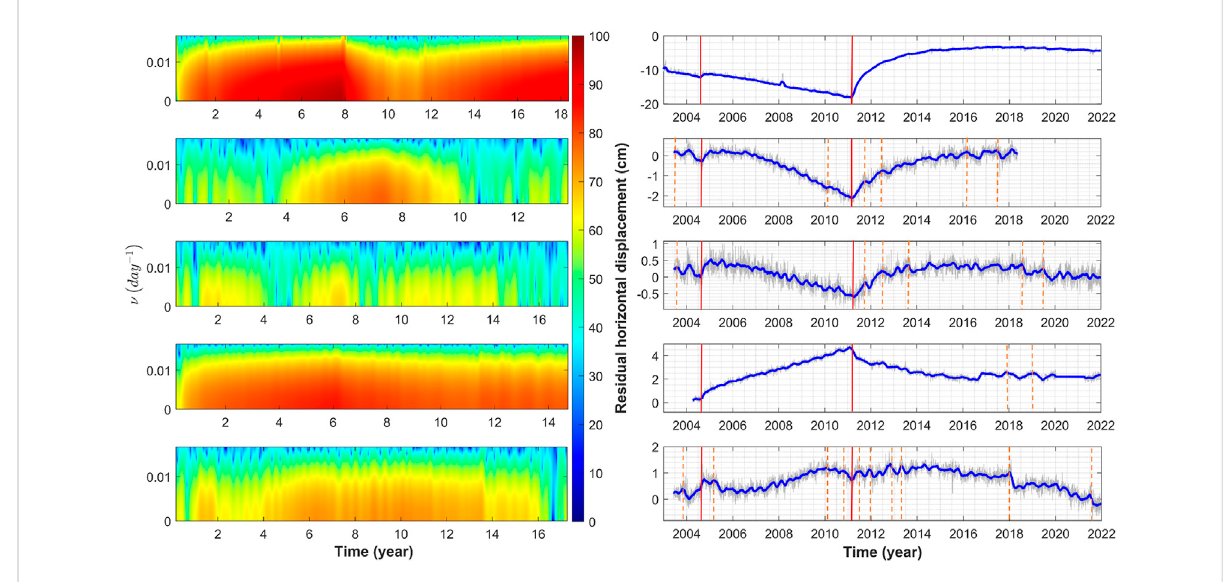
FIGURE 11 Spectrogramsanddetrendedhorizontalgeodetictimeseriesof fi veGNSSstationsintheNankairegion.Fromtoptobottom:USUD,G116,G117,SMST,and G120.SSEsareobserved(2004,2010,and2019);moreover,thespectralamplitudesarenoticedtoincreasebeforetheGiantTohoku-OkiEarthquake(11/03/2011, M w 9.0) in the recordings of stations to the north and nearer to the trench with respect to others. The red lines stand for large earthquakes which caused a measurabledisplacementoftheGNSSstations,whiletheorangedashedlinesrepresentslowslipevents.ThegapsproducedbytheTohoku-Okiearthquake are removed for improving